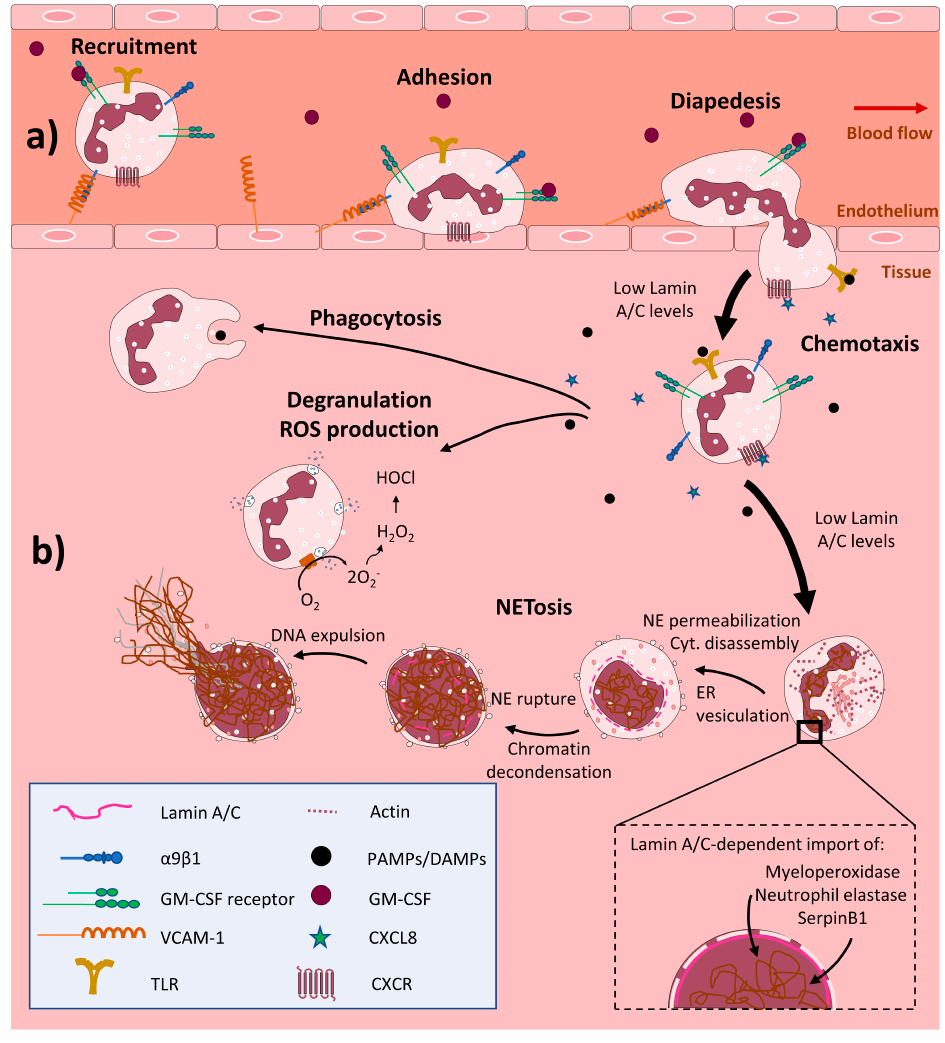
Figure 2. Low lamin A / C expression in neutrophils enables them to pass through narrow spaces during transendothelial migration. Upon infection or tissue damage, neutrophils are rapidly recruited from the circulation to tissues in response to chemoattractants such as CXCL8. The transmigration of neutrophils across the endothelium is mediated by interaction between integrin α 9 β 1 expressed on neutrophils and VCAM-1 expressed on the activated endothelium. Stimulation of neutrophils by GM-CSF during recruitment augments their lifespan. Neutrophils recognize PAMPs or DAMPs through the activation of TLRs and contribute to the resolution of infection through phagocytosis, the release of granules and ROS, and the formation of neutrophil extracellular traps (NETs) NETosis. Neutrophils engage several cellular mechanisms during the generation of NETs (NETosis): disassembly of the cytoskeleton, endoplasmic reticulum vesiculation, chromatin decondensation, plasma membrane and nuclear envelope permeabilization, nuclear lamin meshwork and nuclear envelope rupture to release DNA to the cytoplasm, and plasma membrane rupture and expulsion of DNA to the extracellular environment. ( a ) The low content of lamin A / C in neutrophils allows them to distort their nuclei and pass through narrow spaces during transendothelial migration. ( b ) During NETosis, low lamin A / C content facilitates nuclear envelope rupture. This event also involves nuclear transport of cytoplasmic granule proteins, and low lamin A / C might be also facilitate in this process by easing the control of transport across nuclear pore complexes. GM-CSF, granulocyte-macrophage colony-stimulating factor; VCAM-1, vascular cell adhesion molecule 1; TLR, toll-like receptor; PAMPs, pathogen-associated molecular patterns; DAMPs, damage-associated molecular patterns; CXCL8, C-X-C motif chemokine ligand 8; CXCR, CXC chemokine receptor; ER, endoplasmic reticulum; NE, nuclear envelope; Cyt.,